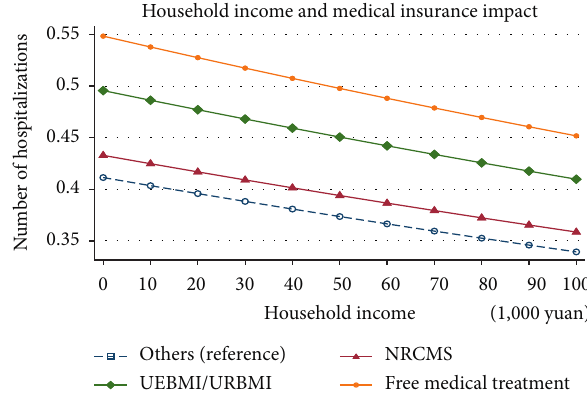
Figure 8: Household income and medical insurance impact. Figure 9: Education and medical insurance